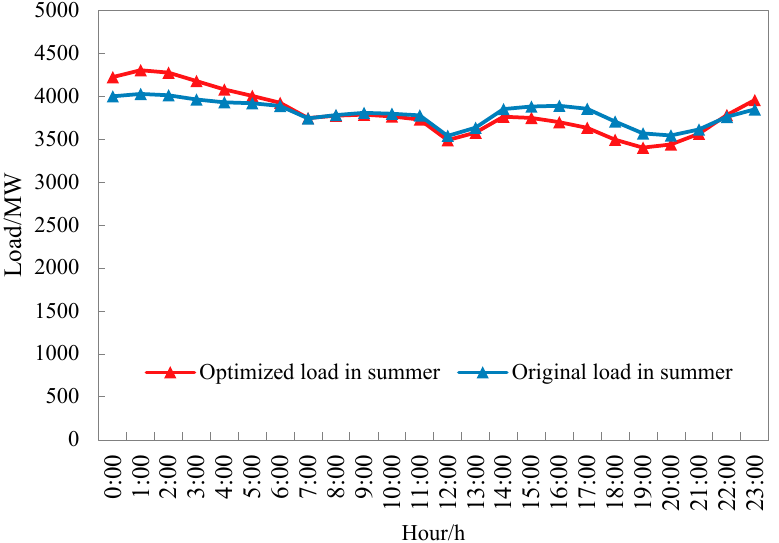
Figure 4. The load optimization results in summer. Compared with the original tariff, the tariff in the peak period increased by 15.39%, and the tariff in the valley period decreased by 18.48%. Due to the adjustment of electricity prices, users spontaneously change their electricity consumption behavior. As shown in Figure 4, the maximum load growth during the valley period reached 6.84% (1:00 a.m.), and the maximum load reduction during the peak hours reached 5.72% (17:00 p.m.).